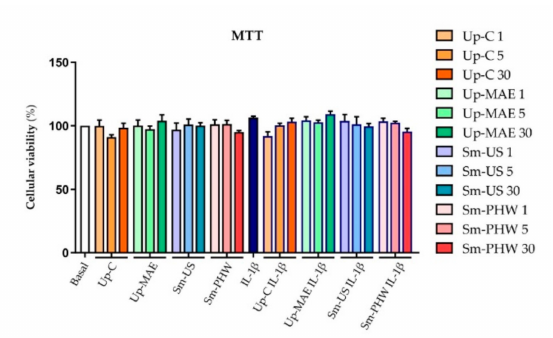
Figure 6. Effect of crude fucoidans and U. pinnatifida commercial fucoidan on cell viability of 260TT cell line. Cell viability was measured by MTT assay ( n = 4) within the different experimental conditions: non-treated (basal), and treated with Up-C, Up-MAE, Sm-US, and Sm-PHW at three different concentrations (1, 5, and 30 µ g/mL) with and without IL-1 β . There are no significant differences between any of the conditions respecting the basal one nor the one stimulated only with IL-1 β ( p -value >